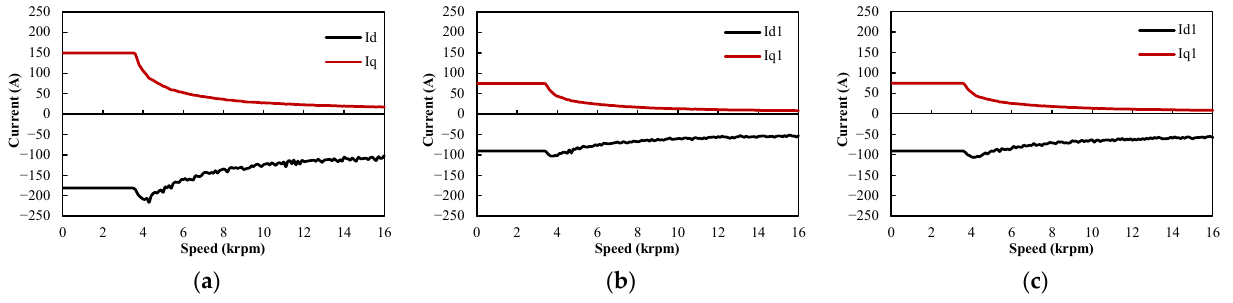
Figure 29. d- and q-axis currents of different winding configurations over entire speed range: ( a ) ORG; ( b ) DTP-SF; ( c ) DTP-DS.